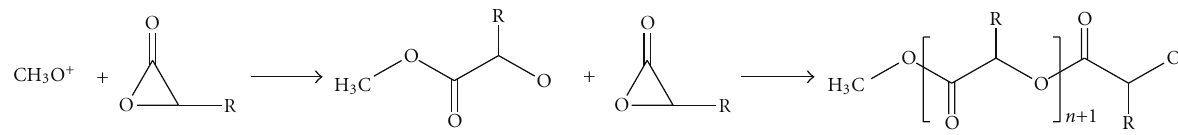
Scheme 8: Anionic polymerization of lactone showing acyl-oxygen scisson.